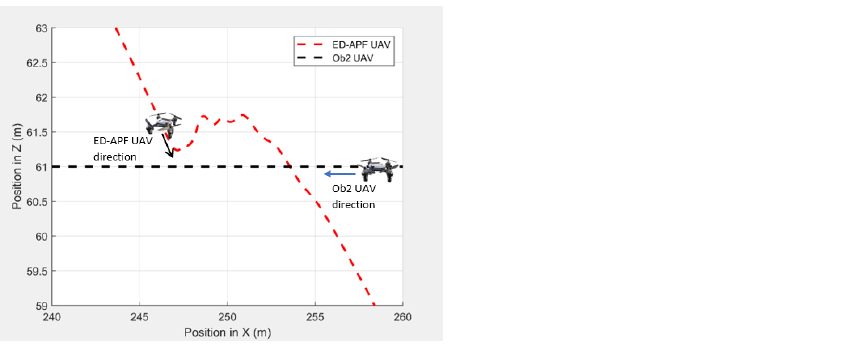
Figure 25. The UAV’s planned path for dynamic obstacle avoidance before encountering another UAV (Ob2).